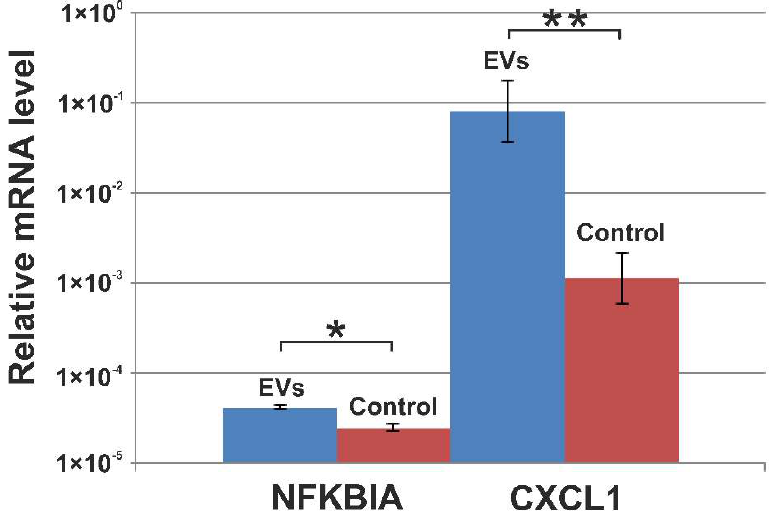
Figure 5. Relative NFKBIA and CXCL1 transcripts levels were evaluated by RT-qPCR following the incubation of A549 cells with EVs and in non-treated cells (Control). Cells were incubated with human blood EVs for 24 h. qPCR levels were normalized to the expression of GAPDH. The results are representative of four replicates (mean ± SD). * Indicates significant differences at p < 0.05 for NFKBIA and ** p < 0.01 for CXCL1 (Student’s t -test).